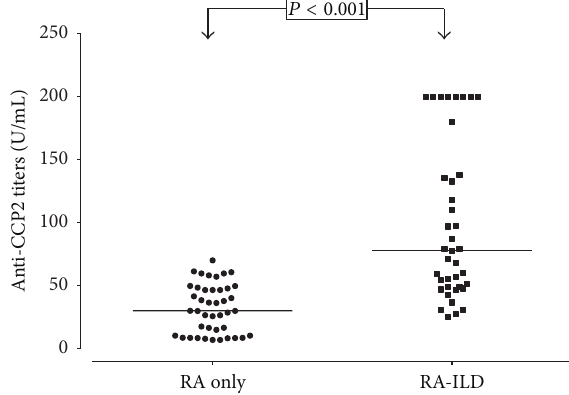
Figure 2: Anti-cyclic citrullinated peptide (anti-CCP2) titers in patients with rheumatoid arthritis without interstitial lung disease (RA-only), compared with patients with rheumatoid arthritis and interstitial lung disease (RA-ILD) group. The cut-off value of anti- CCP2 for positivity was 20U/mL. Horizontal bars indicate the median. 𝑃 values for the comparison of anti-CCP2 titers between groups were obtained by Mann-Whitney 𝑈